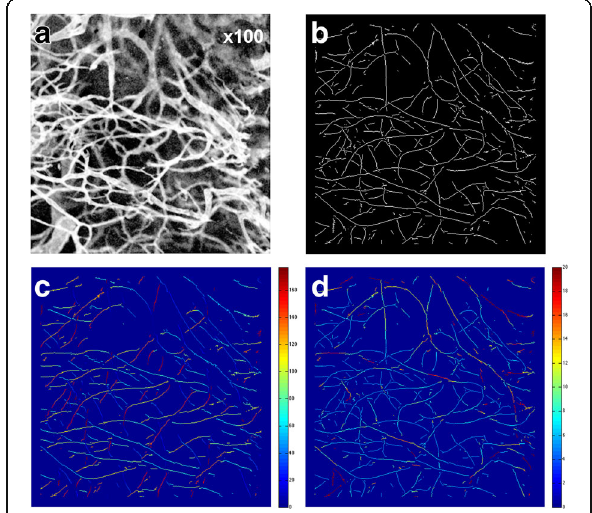
Fig. 1 An example of vessel analysis from CD31 immunohistochemistry images. a Original image. b The binary line image. c Orientation image indicating the angulation of vessels ( scale represents degrees from 0 to 180). d Scale image representing the size of individual vessels ( scale represents